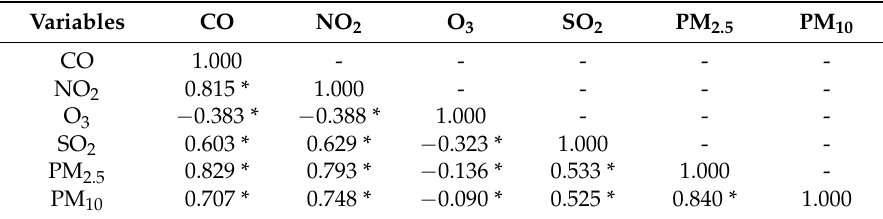
Table 2. Correlation between the